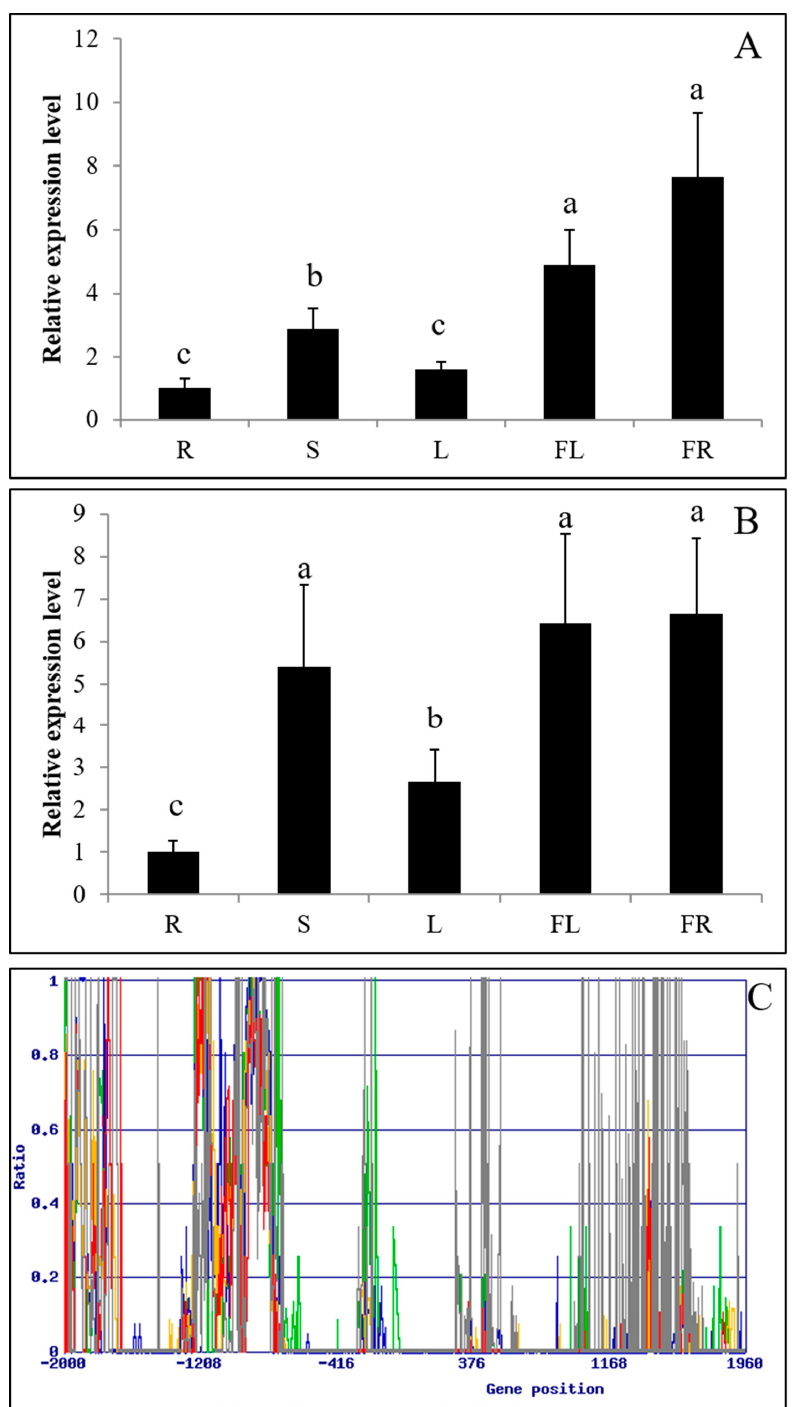
Figure 3. Tissue expression and methylation analysis of PKE1 : gene expression profile in di ff erent tissues (R: root, S: stem, L: leaf, FL: flower, FR: fruit) of S. pennellii LA0716 ( A ) and S. lycopersicum cv. M82 ( B ). All samples were collected at the indicated time points from three biological replicates for each treatment condition. Error bars indicate ± SE of means at p < 0.05 ( n = 3). ( C ) Analysis of the DNA methylation of PKE1 promoter and coding sequences at di ff erent tissues and stages. Immature (17 DPA), mature green (MG: 39 DPA), breaker (Br: 42 DPA), and red ripe (Br + 10: 52 DPA), and leaf. Ratio = 5mC / (5mC +